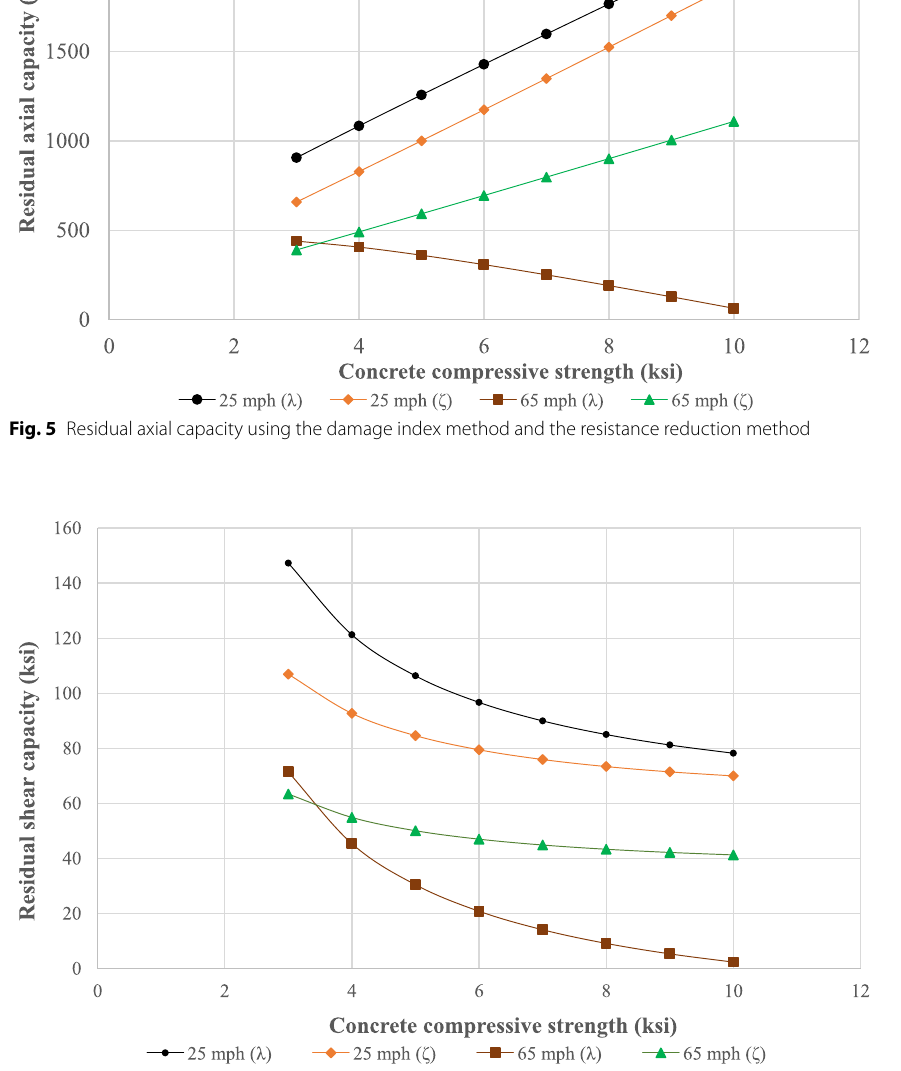
Fig. 6 Residual shear capacity using the damage index method and the resistance reduction